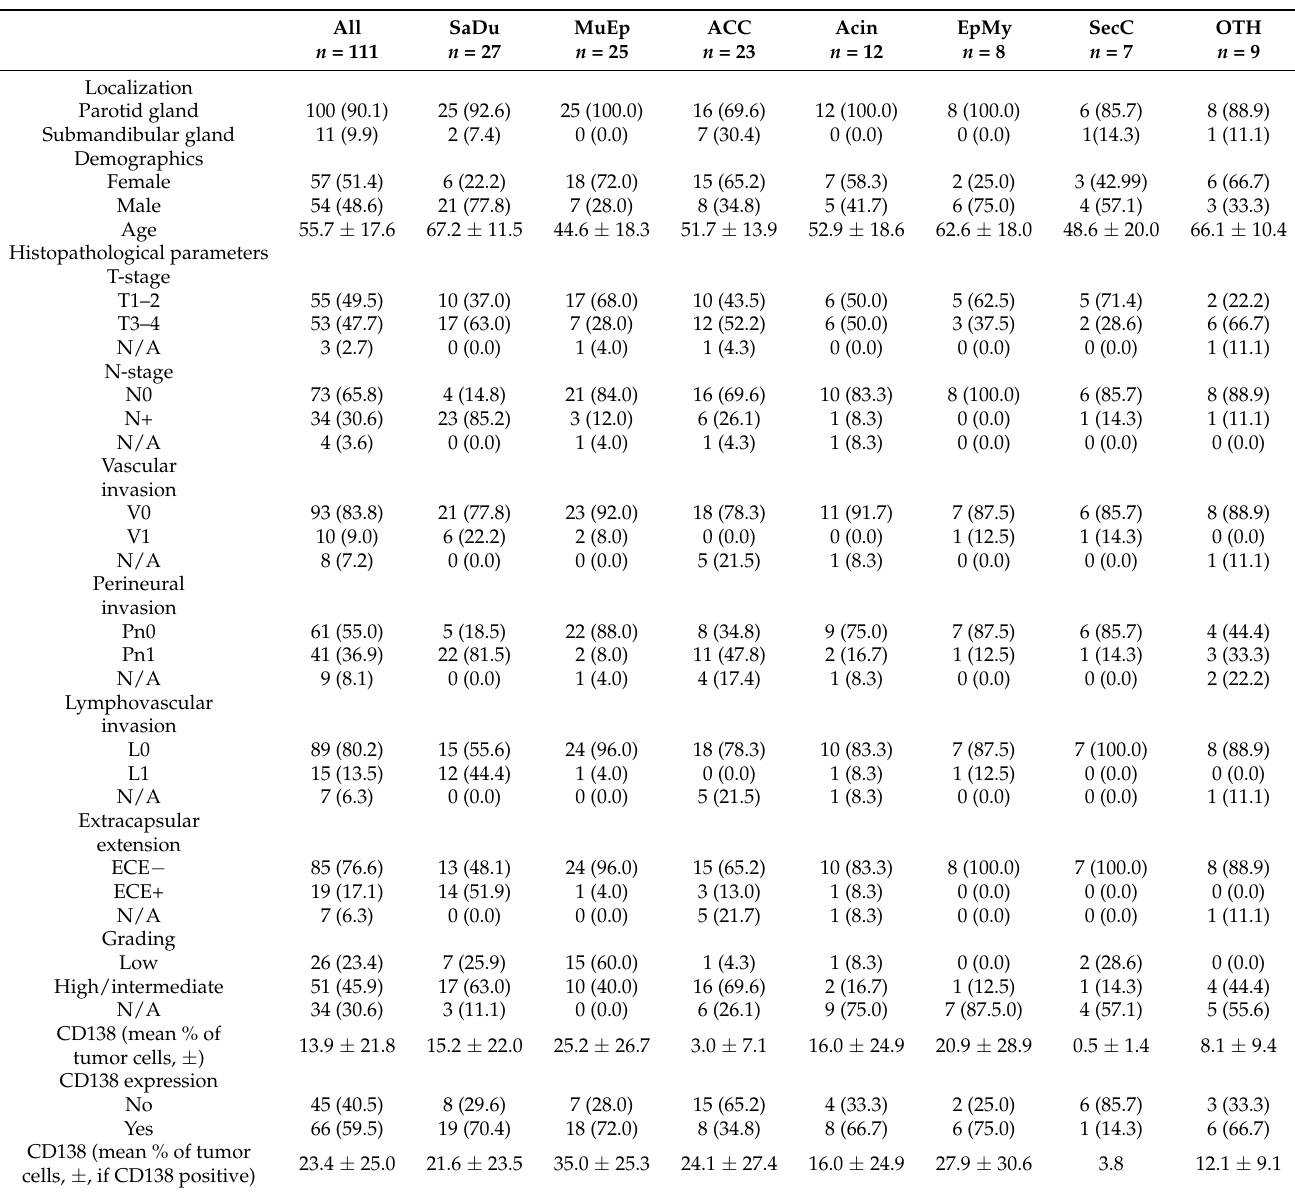
Table 1. Localization of the primary tumor, demographic data, histopathological data, percentage of tumor cells with CD138 expression, and percentage of tumors with CD138 expression for the whole cohort and for the most frequent